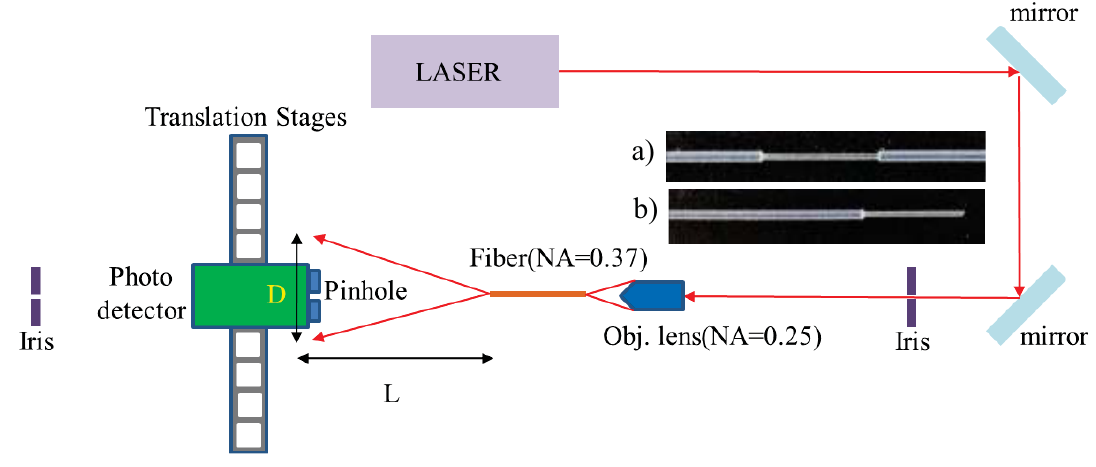
Figure 12. Schematic of the numerical aperture measurement